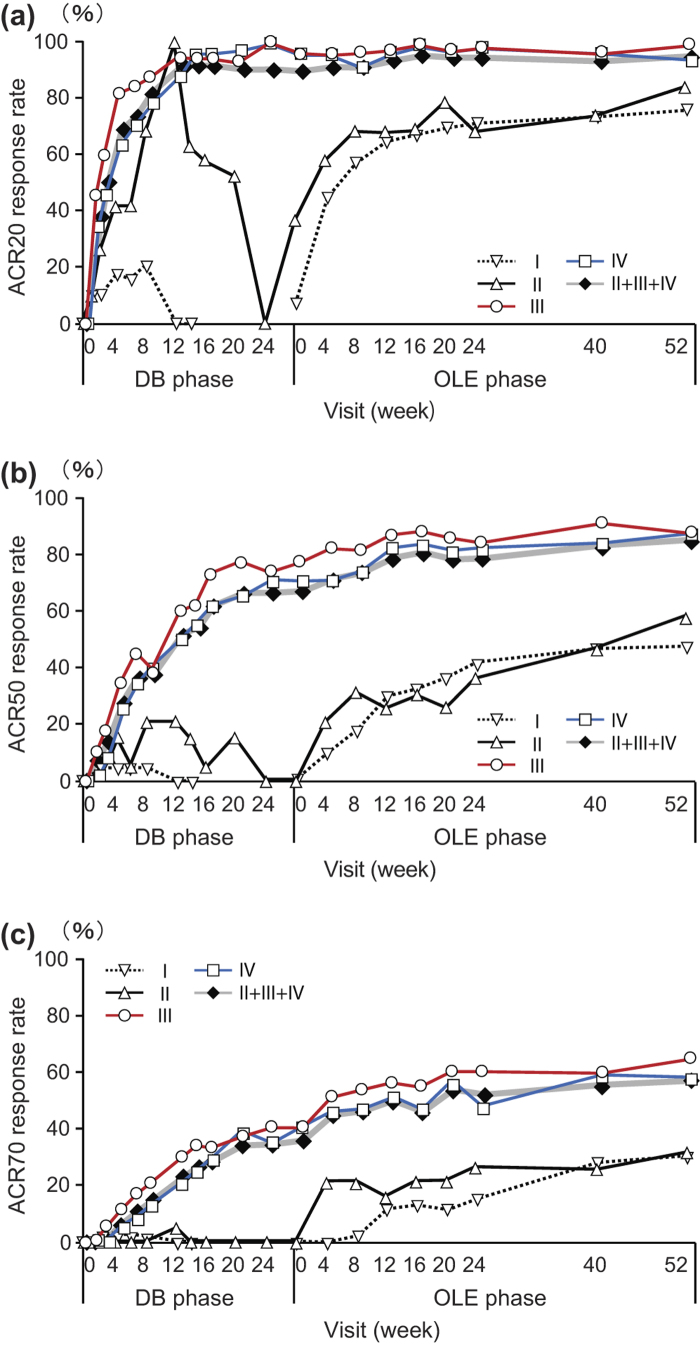
The ACR20/ACR50/ACR70 response rates in patients from each treatment group. The percentages of patients in Groups I (n = 81), II (n = 19), III (n = 93), IV (n = 92) and patients in Groups II + III+ IV combined (DB completers, n = 204) who achieved an (a) ACR20, (b) ACR50, or (c) ACR70 response were plotted over time for the DB and the OLE phase of the study (FAS population, LOCF imputation). Of note, week 0 of the OLE phase of Group I (early escape) corresponds to week 16 of the DB phase. There are no points in the missing section of the graph for Group I.